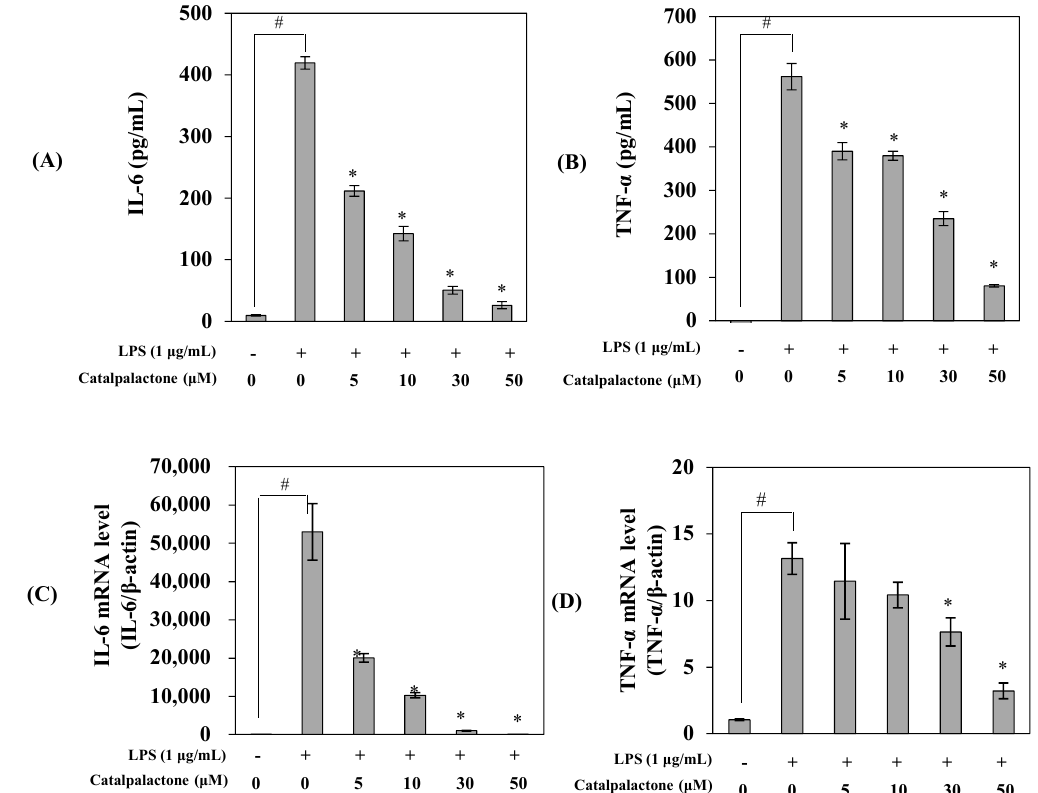
Figure 3. Inhibitory effects of catalpalactone on interleukin-6 (IL-6) production ( A ), tumor necrosis factor- α (TNF- α ) production ( B ), IL-6 mRNA production ( C ), and tumor necrosis factor- α (TNF- α ) mRNA ( D ) levels in LPS-stimulated RAW264.7 cells. The cells were pretreated with various concentrations of catalpalactone (5, 10, 30, and 50 µ M) for 2 h and then stimulated with or without LPS (1 µ g/mL) for 18 h. IL-6 and TNF- α production was assessed using enzyme-linked immunosorbent assay kits. IL-6 and TNF- α mRNA expression was measured via quantitative real-time PCR. Data are presented as the mean ± SD ( n = 3). # p < 0.05 vs. control cells, * p < 0.05 vs. LPS-treated cells.